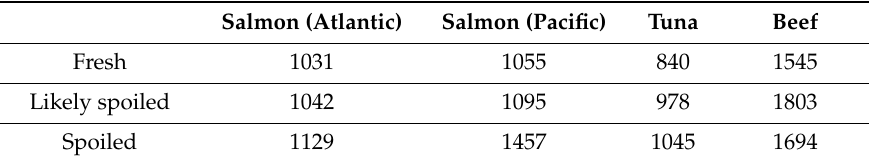
Table 2. The number of spectra collected for each food category.